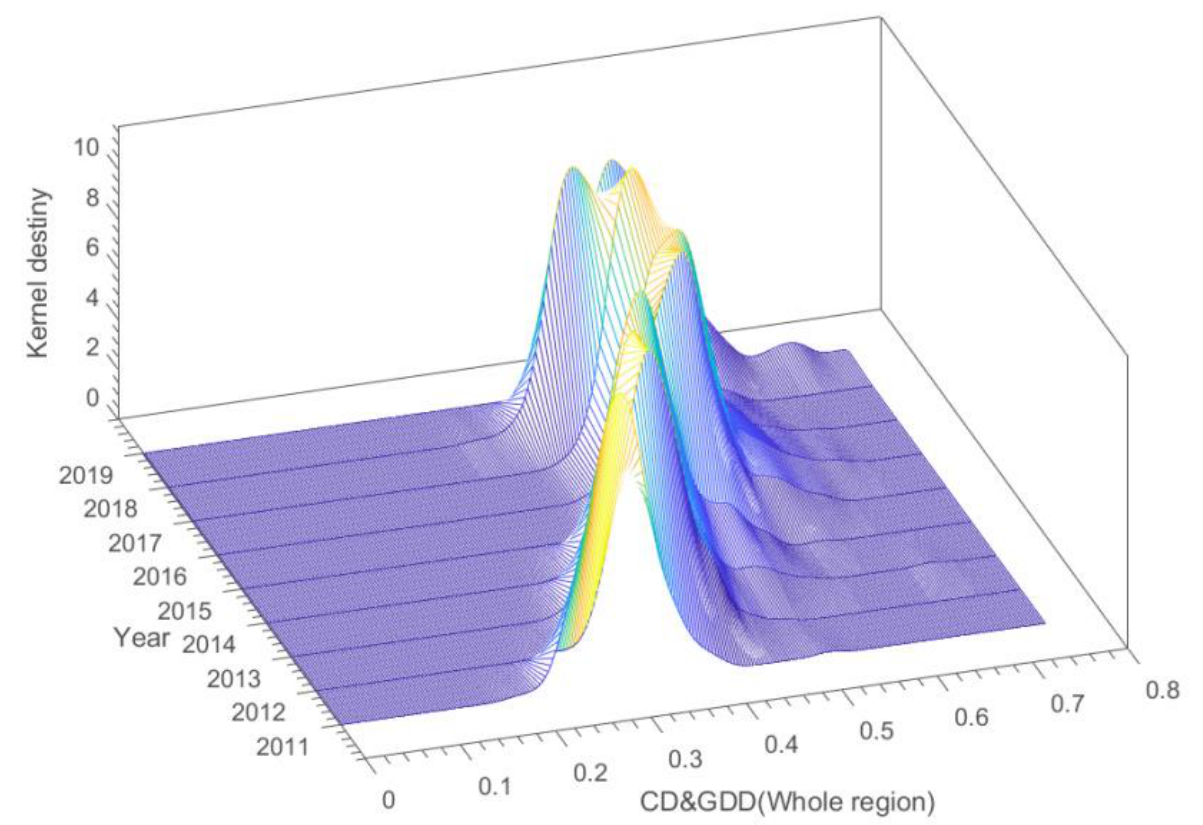
Figure 7. Three-dimensional kernel density map of China ’ s CD&GDD.